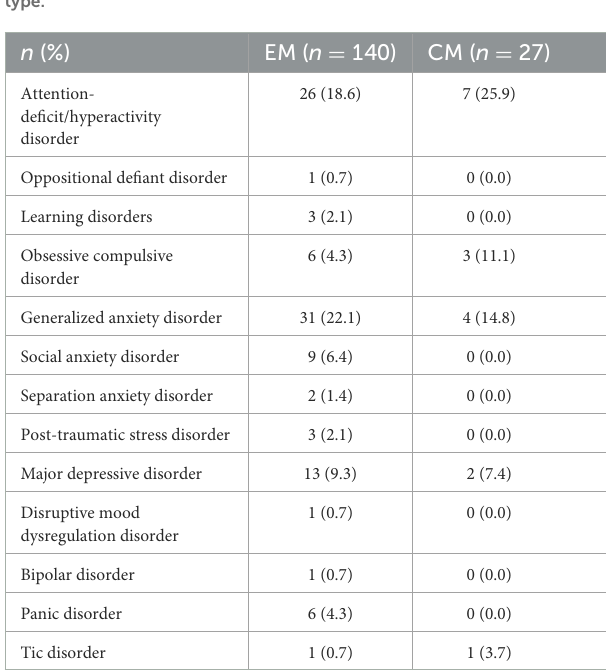
TABLE 2 Psychiatric diagnoses of the respondents according to migraine